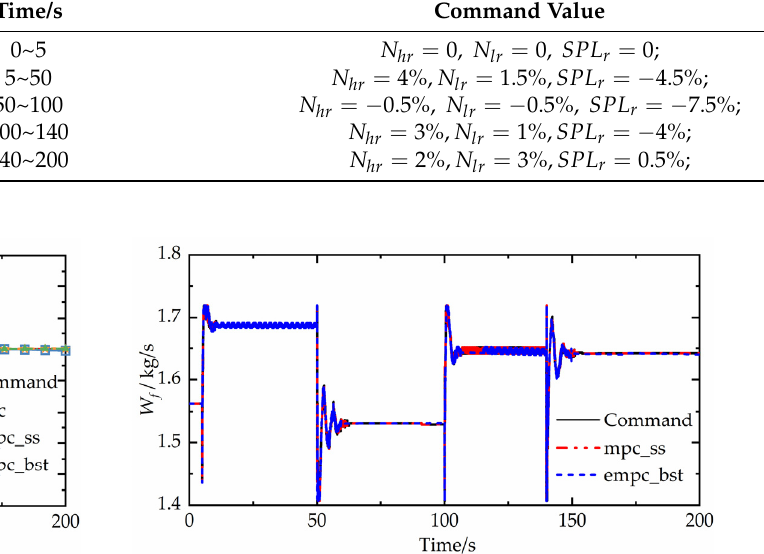
Table 2. The range of control command.